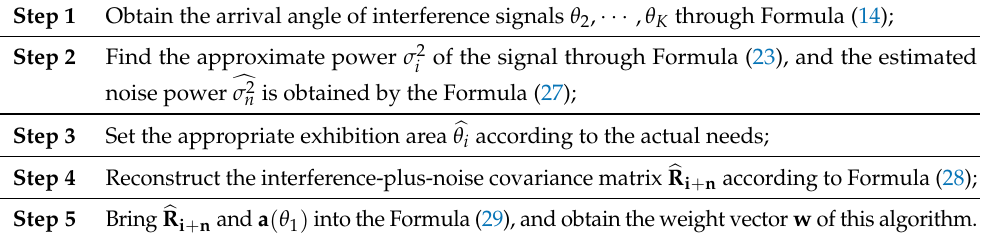
Table 1. The proposed algorithm